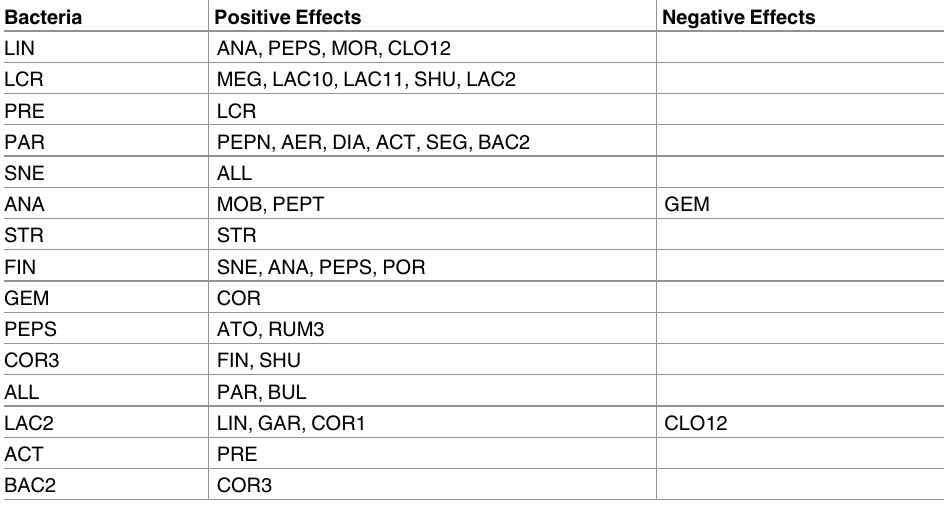
Table 4. Interactions among bacteria for subject 6. See legendfor Fig 2 for OTU